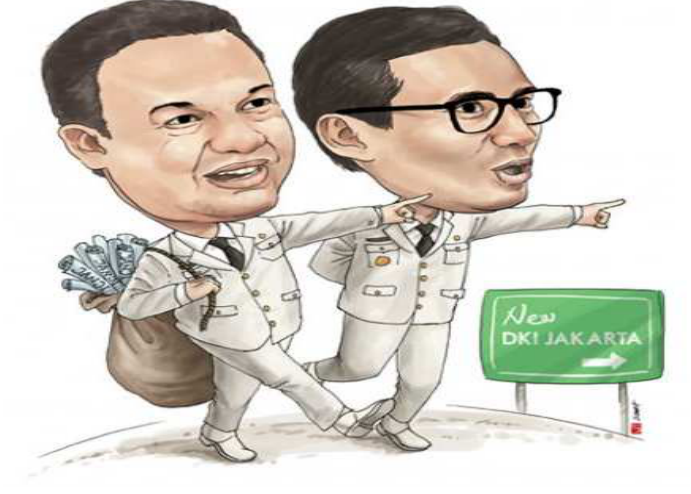
( source: Mediaindonesia.com )